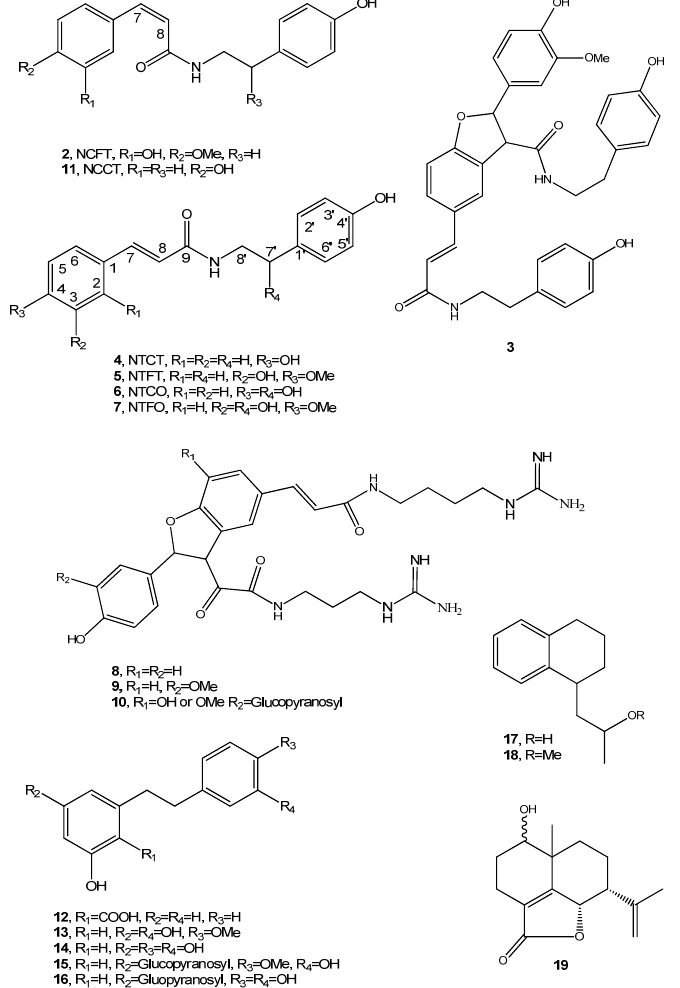
Figure 2. The structures of compounds 2 – 19 .